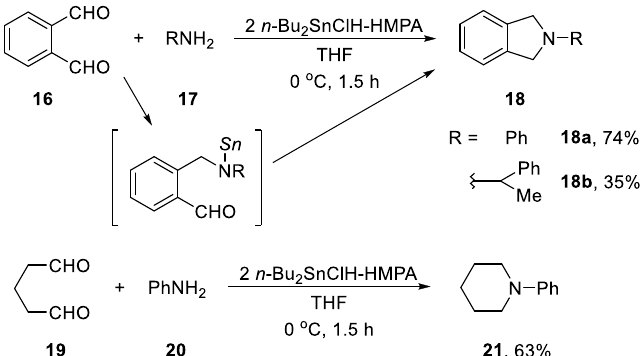
Scheme 6. Reductive amination of dialdehydes with primary amines.